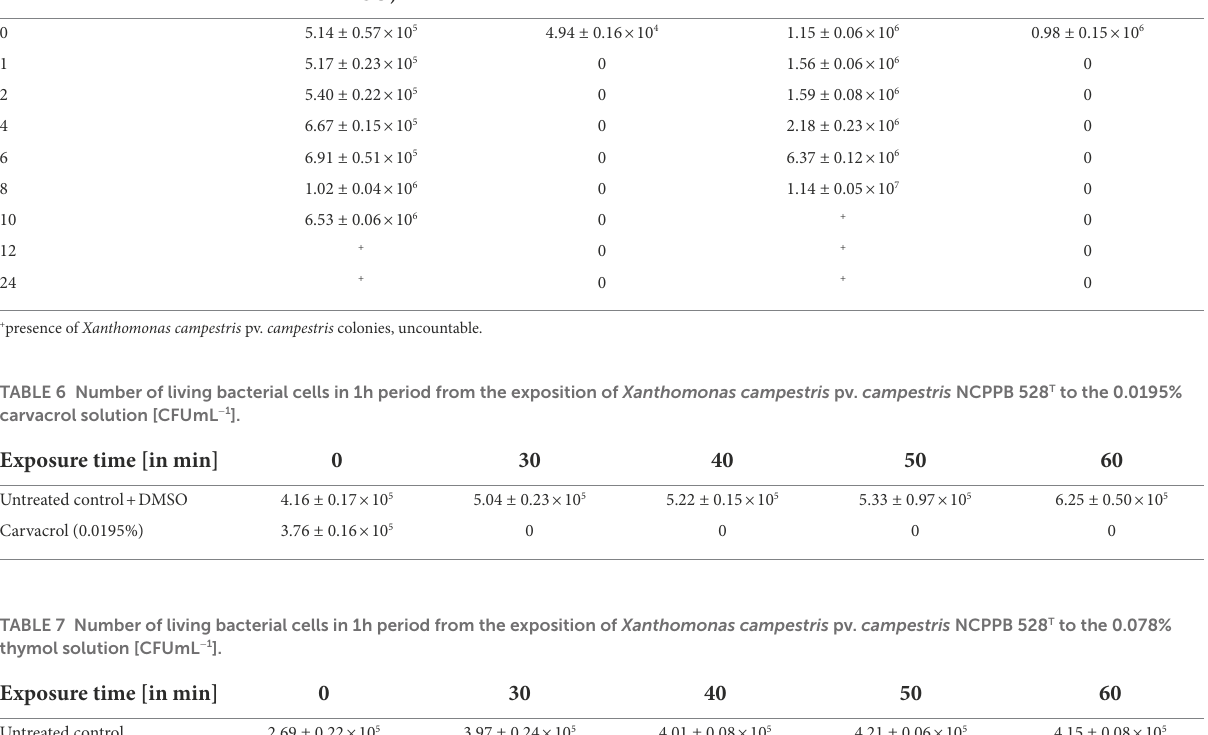
Exposure time [in h]